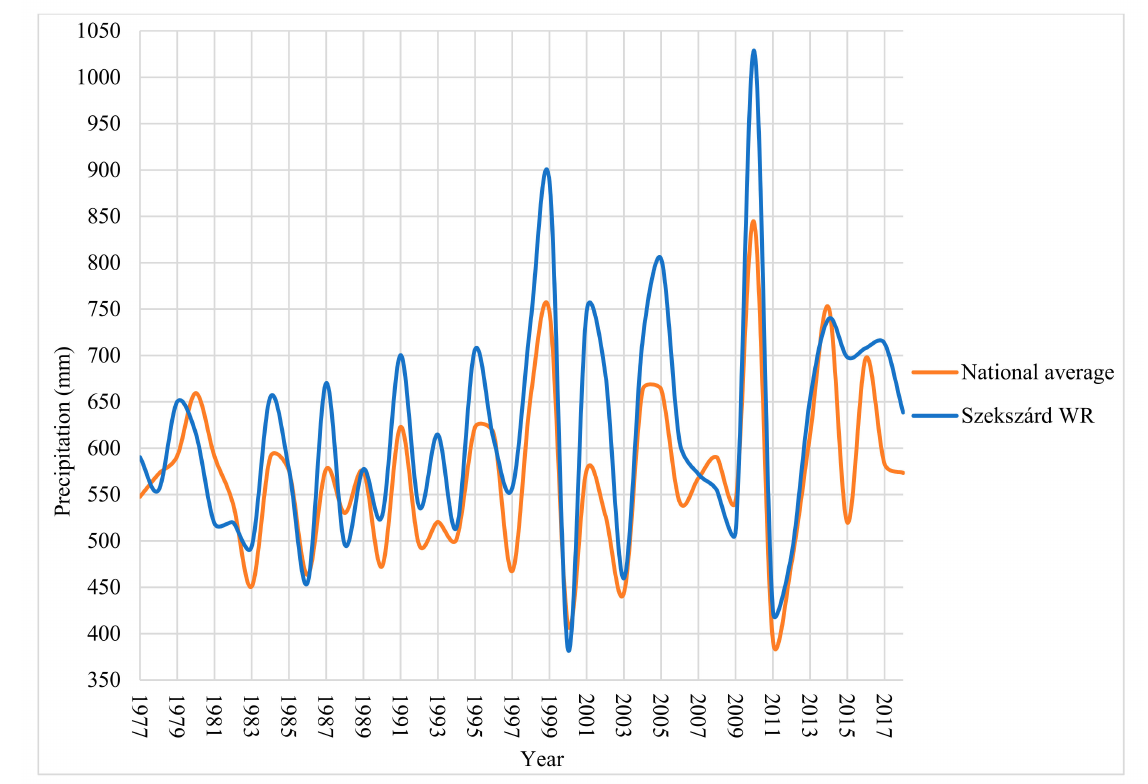
Figure 5. The cumulated annual precipitation (1977–2018) of Szeksz á rd wine region and Hungary.